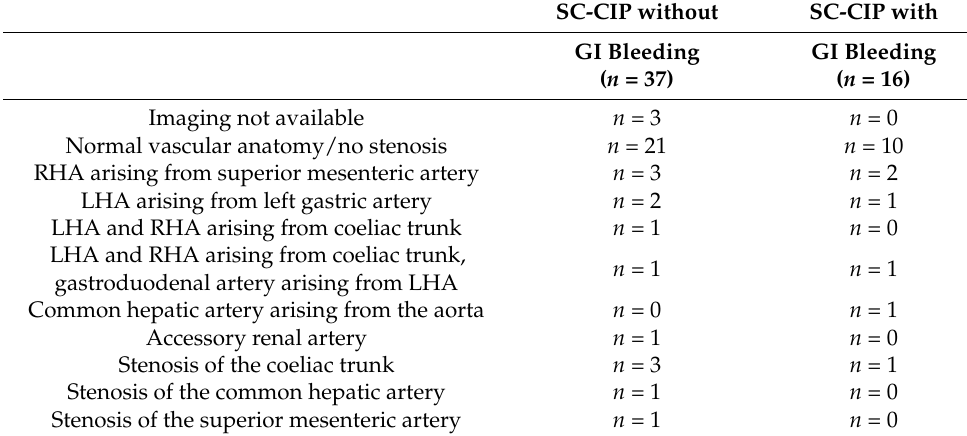
Table 5. Description of alterations of the vascular anatomy of SC-CIP patients indicating standard variants and vascular stenosis. The SC-CIP cohort is divided by the occurrence of GI